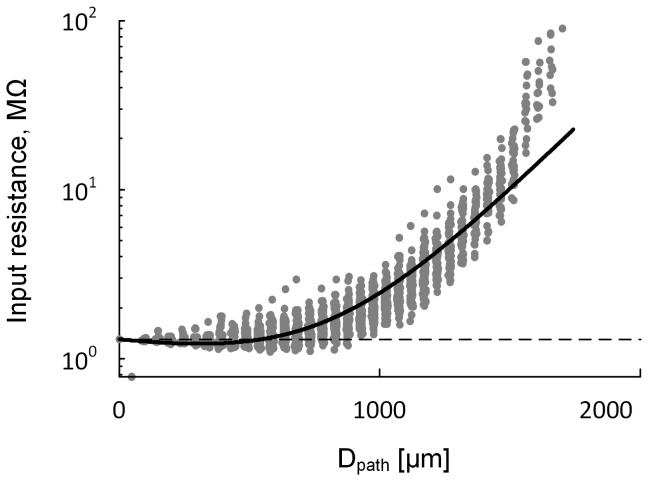
Dependence of input resistance at the dendrites on the DC VA factors.Input resistance (RN,D, gray dots) was measured at individual points of the motoneuron dendrites at the same distance with respect to the total current injected to the dendrites (see the stimulation protocol used for the VADS
DC). The measured RN,D was superimposed by the RN,D (black line) that was predicted from fitting curves to the DC VA data using the equation (RN,D(Dpath) = RN*VASD
DC(Dpath)/VADS
DC(Dpath) where RN is input resistance at the soma (Dpath = 0)). Note the agreement between the predicted and measured input resistance in the dendrites. The poor fit at the distal distance was attributed to the error between the VADS
DC data and its fitting curve (see Figure 1(A)).